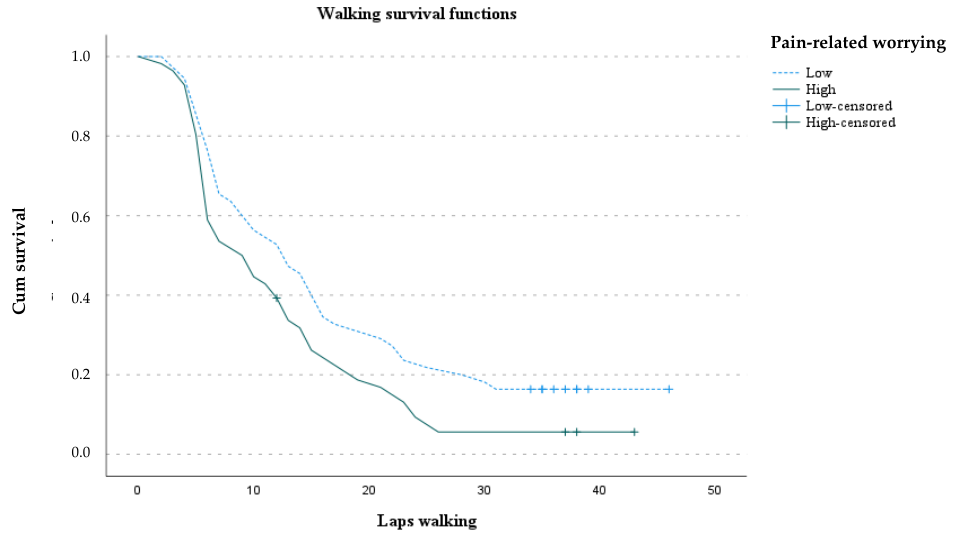
Figure 1. Walking maintenance along the walking task.